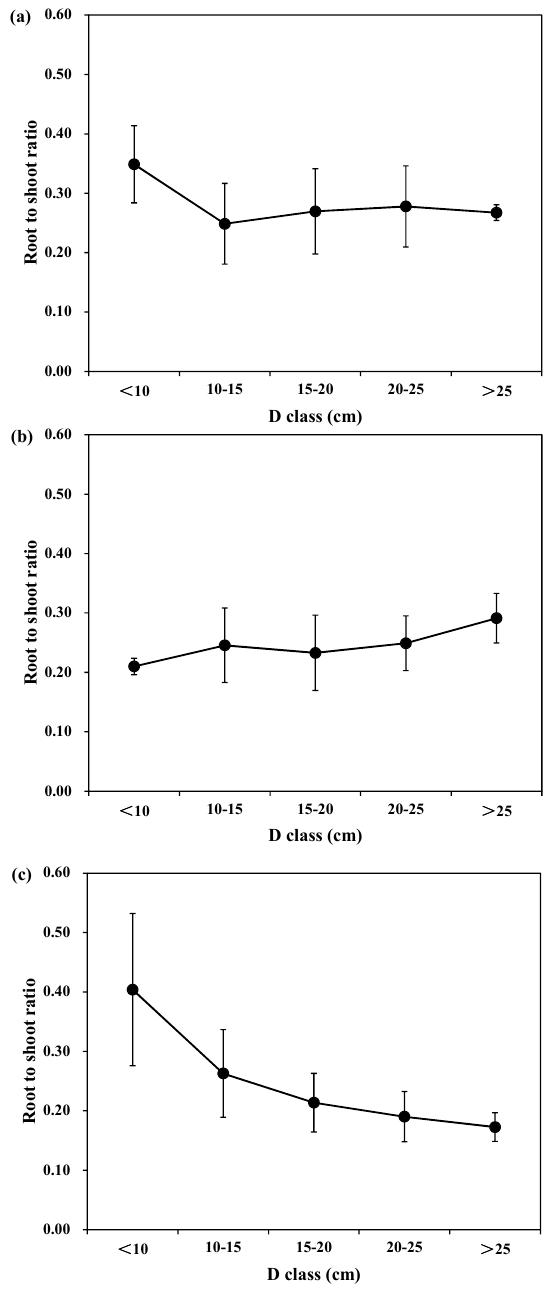
Figure 3. Root to shoot biomass ratios for Korean pine, larch and Mongolian pine across a range of diameter classes (the first column; <10 cm, 10–15 cm, 15–20 cm, 20–25 cm and >25 cm): ( a ) Korean pine; ( b ) Larch; and ( c ) Mongolian pine.